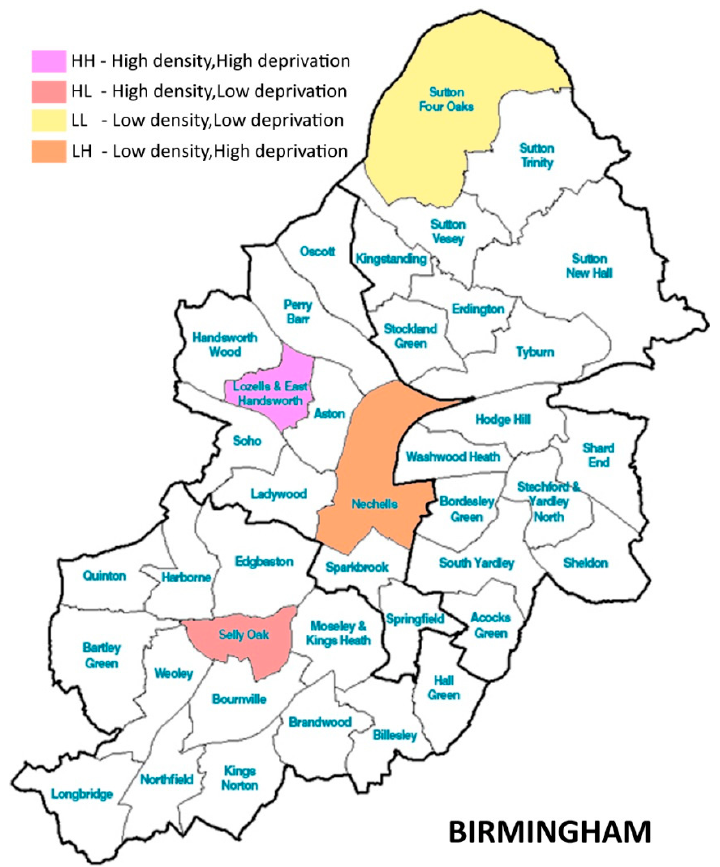
Figure 1 . Four wards identified for case studies. Source: Author. Figure 1. Four wards identified for case studies. Source: